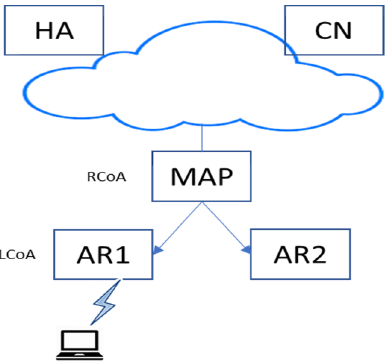
Figure 4. Hierarchical Mobile Internet Protocol (MIP).